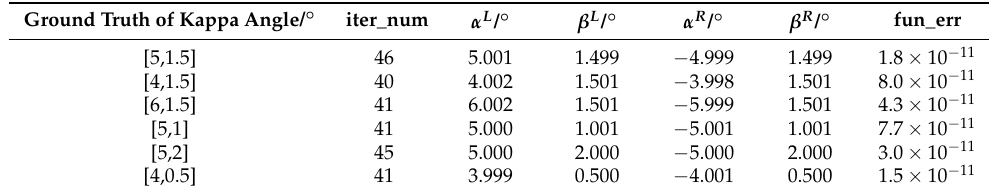
Table 2. Kappa angle calibrated from different sets of ground truth.